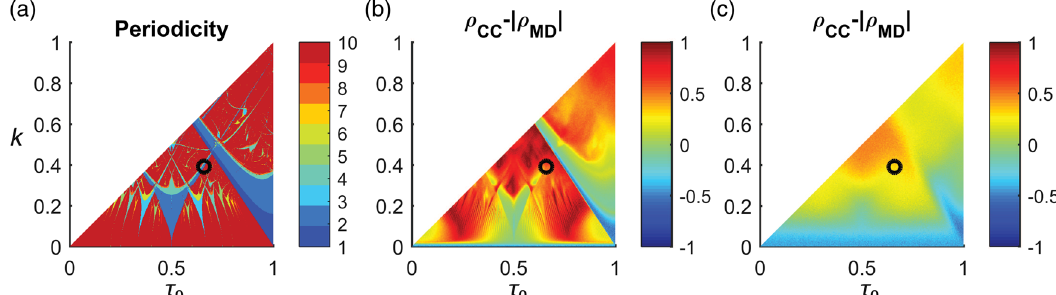
3. Features of the kicked cell-cycle model with and without noise, α ¼ − 0 . 5 . (a) Periodicity map showing the Arnold tongues in the absence of noise. For example, dark blue denotes a fixed point region, light blue denotes a period 2 region, and dark red denotes either periods higher than 10 or quasiperiodic and chaotic regions. (b),(c) Visualization of the cousin-mother inequality [Eq. (8)] for a noise level of ξ ¼ 0 . 01 (b) and for ξ ¼ 0 . 1 (c), which represent the lower and upper bounds of the measured experimental noise (see Table II). The black circle denotes the fit parameters to the data set Cyanobacteria 1. τ 0 , k , and ξ are in units of T